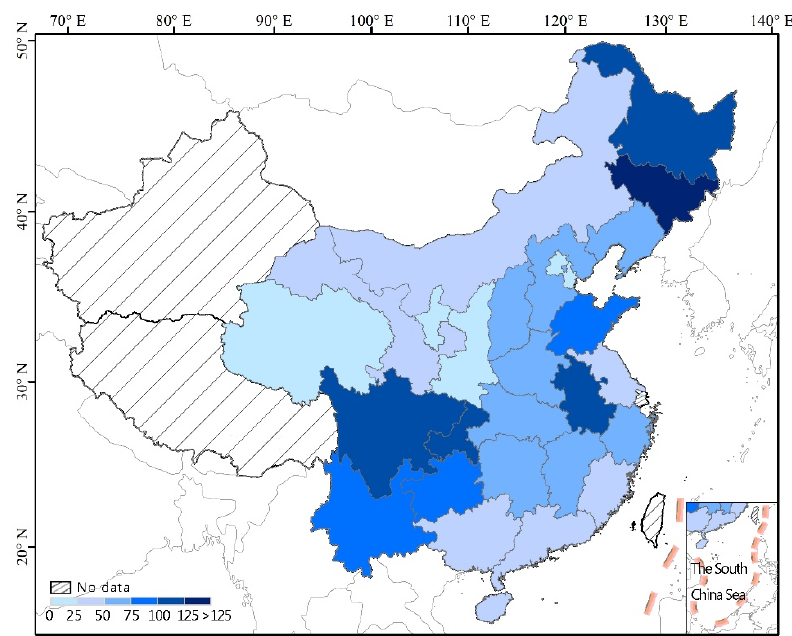
Figure 3. Sample size